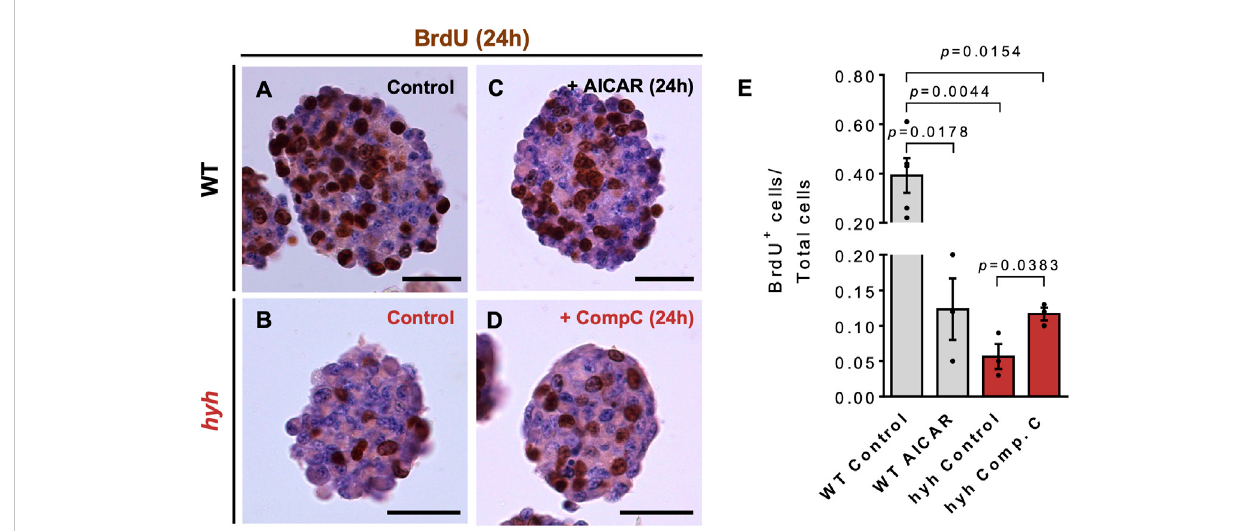
FIGURE 7 NSPCs derived from hyh mice show reduced proliferation rate, which is reversed through pharmacological modulation of AMPK. (A – D) . Representative sections of neurospheres WT (A,C) and hyh (B,D) mice cultured for 7 days in vitro (DIV) and immunostained for BrdU and counterstained with Hematoxylin. BrdU (20 mmol/L) was added to the cultures 24 h before fi xation. A and B are representative sections from WT (A) and hyh (B) neurospheres with no treatment (control). C and D are representative images of WT neurospheres treated for 24 h with 5 mM AICAR (C) and hyh neurospheres treated with 10 μ M Compound C (D) . (E) . Quanti fi cation of BrdU labeling index (i.e., the fraction of BrdU-positive cells over the total number of cells). The bars represent mean ± SEM (n = 3 – 5). Differences with p < 0.05 were considered signi fi cant (One-way ANOVA with Bonferroni ’ s post-test). Scale Bars: A-D = 30